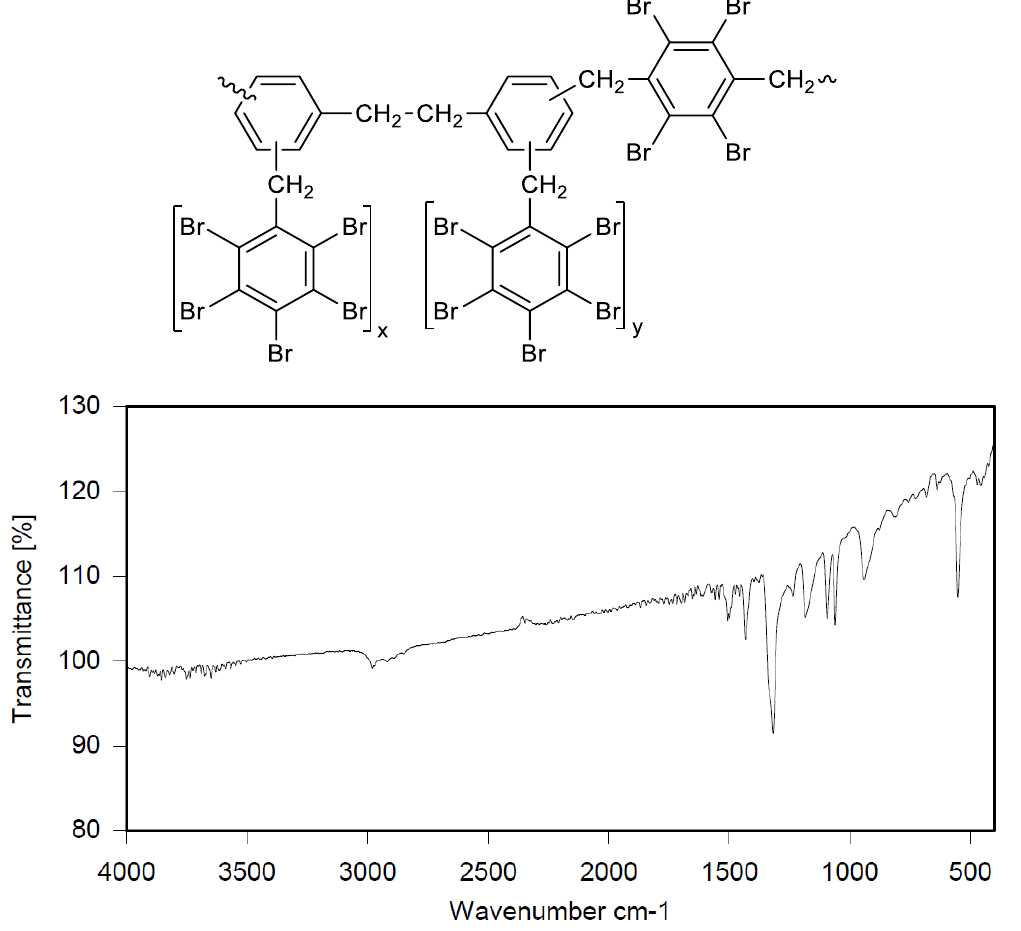
Figure 4. FTIR spectrum of diphenylethane alkylated with PBBB and TBXDB (DPE-PBBB-TBXDB).